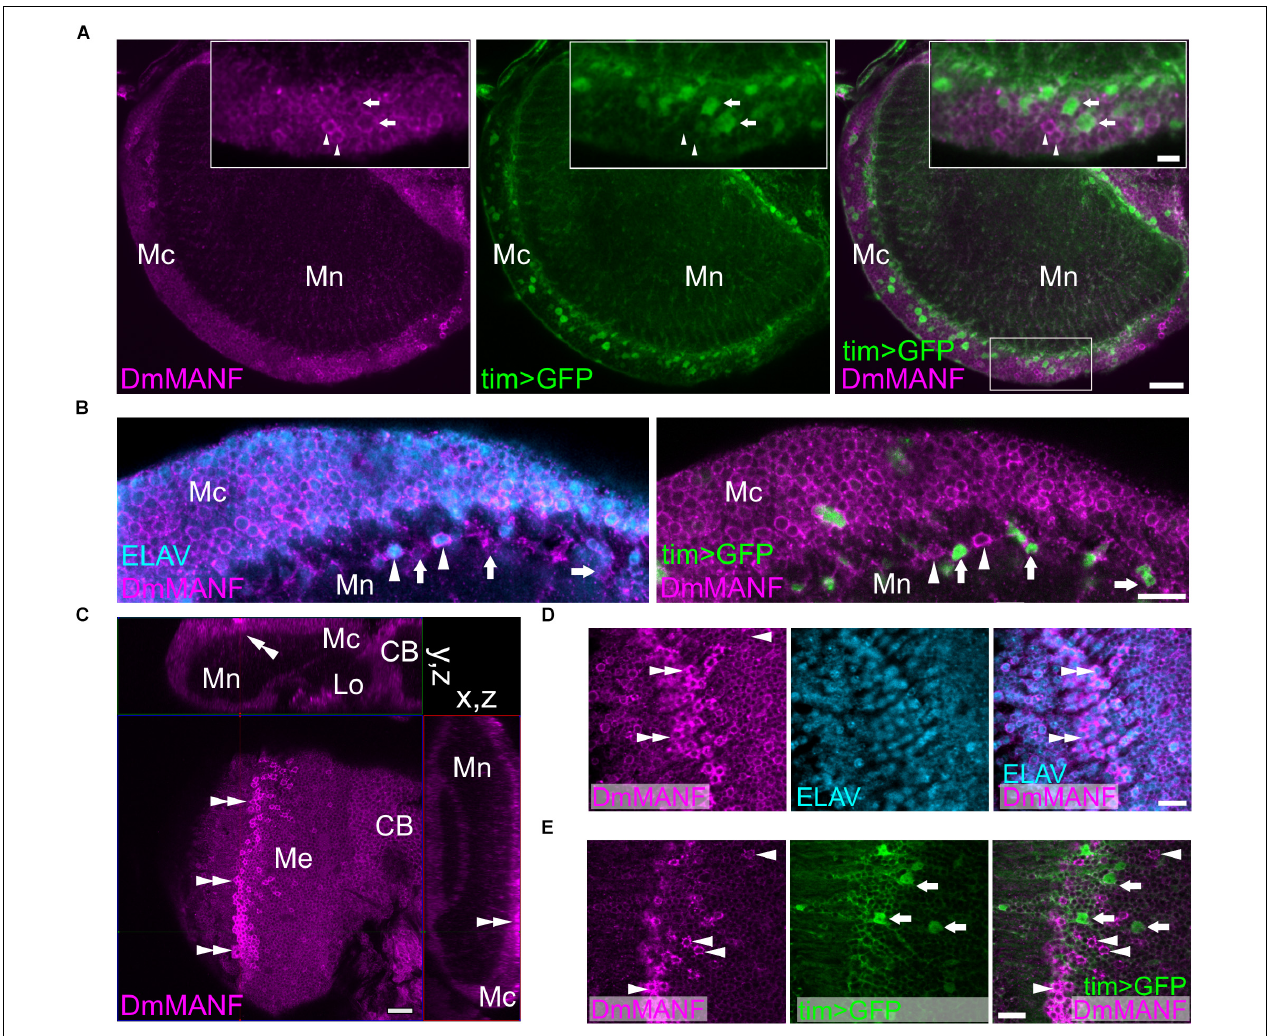
FIGURE 2 | DmMANF expression in the second optic neuropil (medulla). (A) DmMANF is present in the majority of tim-GAL4 driven UAS-S65T-GFP cells in the second optic neuropil, including cell bodies in the medulla cortex and processes in the medulla neuropil. Inserts show enlargements of the medulla cortex. Arrowheads indicate cells with high level of DmMANF and low expression of tim . Arrows show cells which express tim at high level but DmMANF at low level. (B) The majority of DmMANF-positive cells in the medulla cortex represents neurons (labeled with anti-ELAV, a pan-neuronal marker). These neurons also exhibit low level of nuclear UAS-rpl-GFP under tim-GAL4 control. Similarly to the medulla cortex, in the distal part of the medulla neuropil two populations of cells, characterized by high or low levels of DmMANF, were identified. Cells strongly expressing DmMANF are neurons, as they co-expressed ELAV (arrowheads), while a population of cells with low level of DmMANF does not express ELAV but strongly expresses tim (arrows). (C) The cluster of DmMANF-positive cells was also identified on the surface of the medulla (double arrowheads). The figure represents orthogonal view of the optic lobe. (D) Cells with high levels of DmMANF (arrows) express ELAV